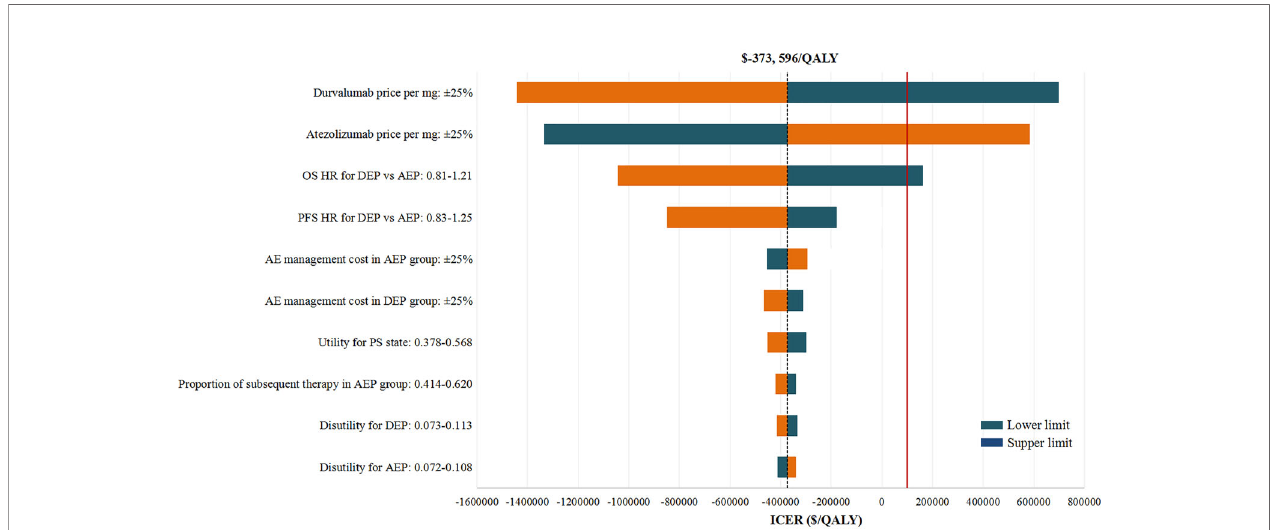
FIGURE 2 | Deterministic Sensitivity Analysis. The red solid line represents the willingness-to-pay threshold of $100,000 used this analysis. The black dotted line represents the incremental cost-effectiveness ratio (ICER) between alternatives under comparison. The top 10 most in fl uential parameters of the ICERs are displayed. AEP indicated atezolizumab combined with etoposide and platinum; DEP, durvalumab combined with etoposide and platinum; QALY, quality adjusted life year; ICER, incremental cost-effectiveness ratio; AE, adverse event; PFS, progression-free survival; PS, progressed